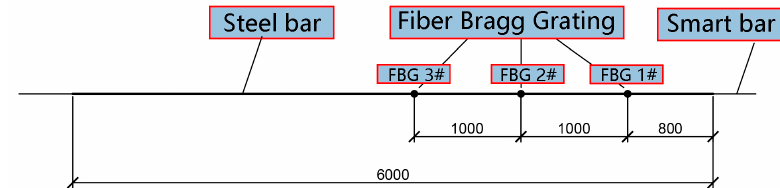
Figure 4. Distribution of the gratings for prestressed smart composite cable No. 1 and No. 2.